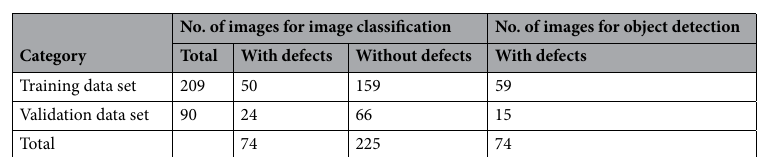
Table 2. Image data set distribution for both image classification and object detection tasks.